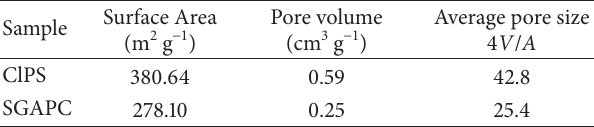
Table 2: Structural parameters for ClPS and